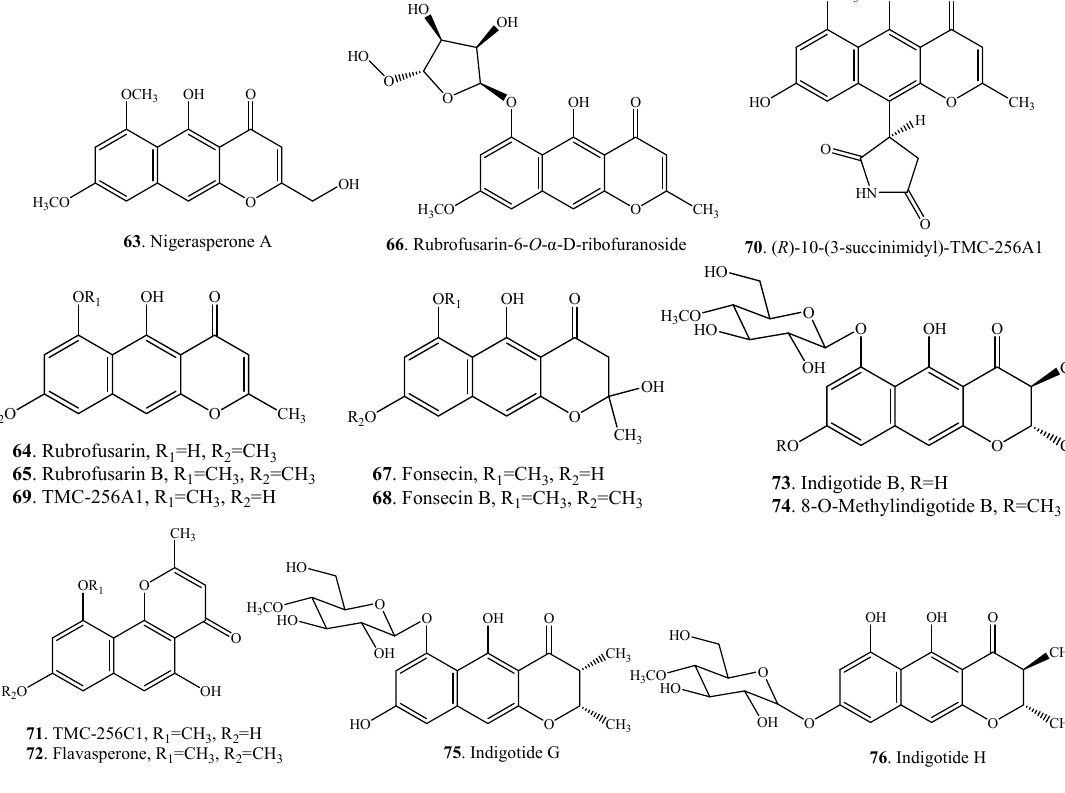
Figure 4. Structures of some monomeric naphtho- γ -pyrones 63 – 76 from fungi. HO OH OOOHO OOHO H 3 CO CH 3 66 . Rubrofusarin-6- O - α -D-ribofuranoside 70 . ( R )-10-(3-succinimidyl)-TMC-256A1